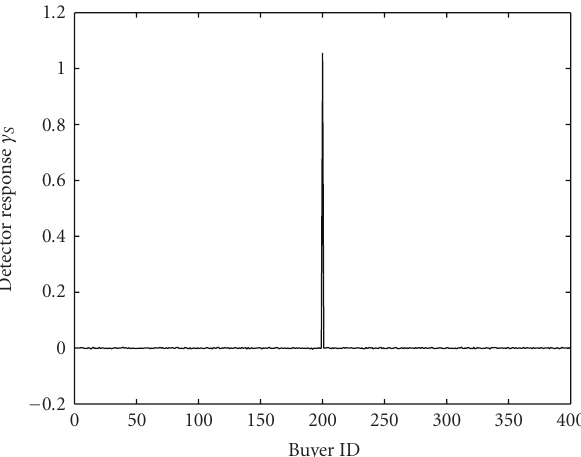
Figure 4: Identifying the malicious buyer by the seller. The seller tests the buyers with the watermark V according to